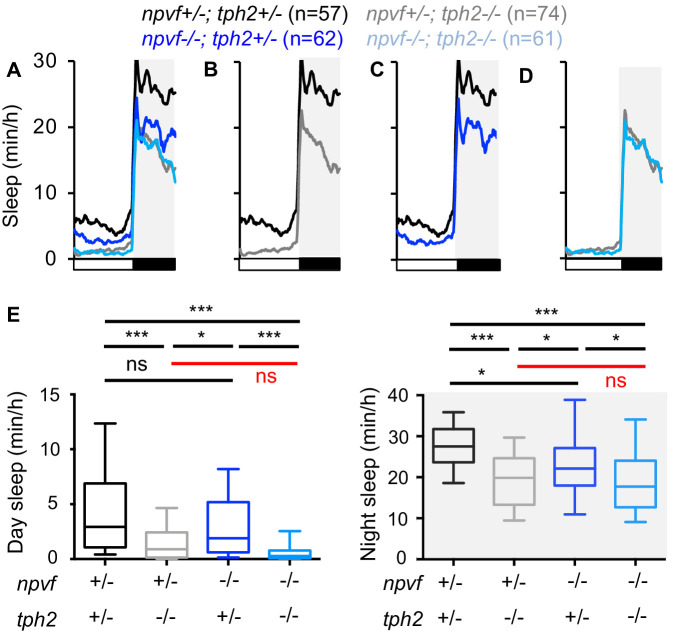
Loss of npvf does not enhance the tph2 mutant sleep phenotype.(A–D) Sleep for npvf +/-; tph2 +/- (black), npvf -/-; tph2 +/- (dark blue), npvf +/-; tph2 -/- (gray), and npvf -/-; tph2 -/- (light blue) siblings. The graph on the left shows data for all four genotypes. The three other graphs show the same data as separate pair-wise comparisons. (E) Box plots quantify sleep during the day (left) and night (right). White boxes indicate day. Black boxes and gray shading indicate night. Data during the fifth day and night of development from four experiments combined is shown. n = number of animals. ns p>0.05, *p<0.05, ***p<0.005, Two-way ANOVA with Holm-Sidak test for each indicated pair-wise comparison. The comparison in red indicates no significant difference between npvf +/-; tph2 -/- and npvf -/-; tph2 -/- siblings.